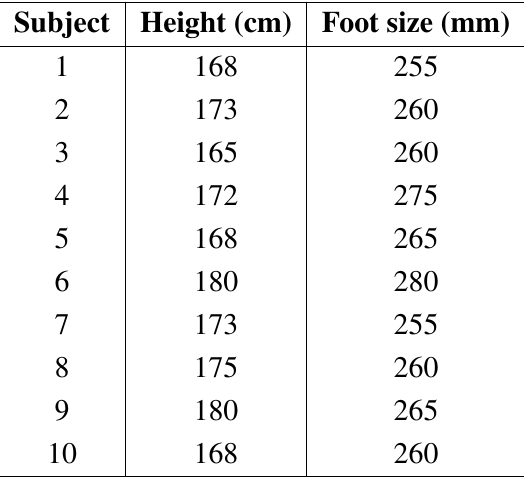
Table 1. Heights and foot sizes of the subjects.